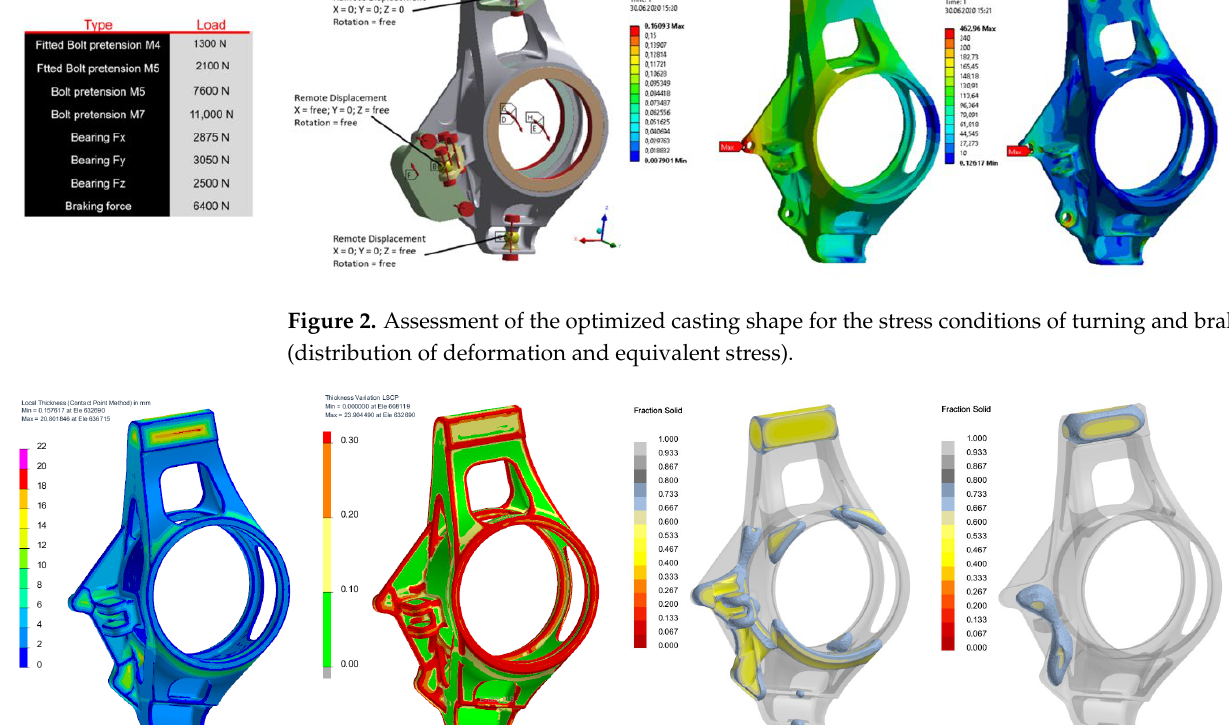
Figure 3. Co-design results. ( a ) Wall thickness analysis; ( b ) Simulation of hot spot formation.